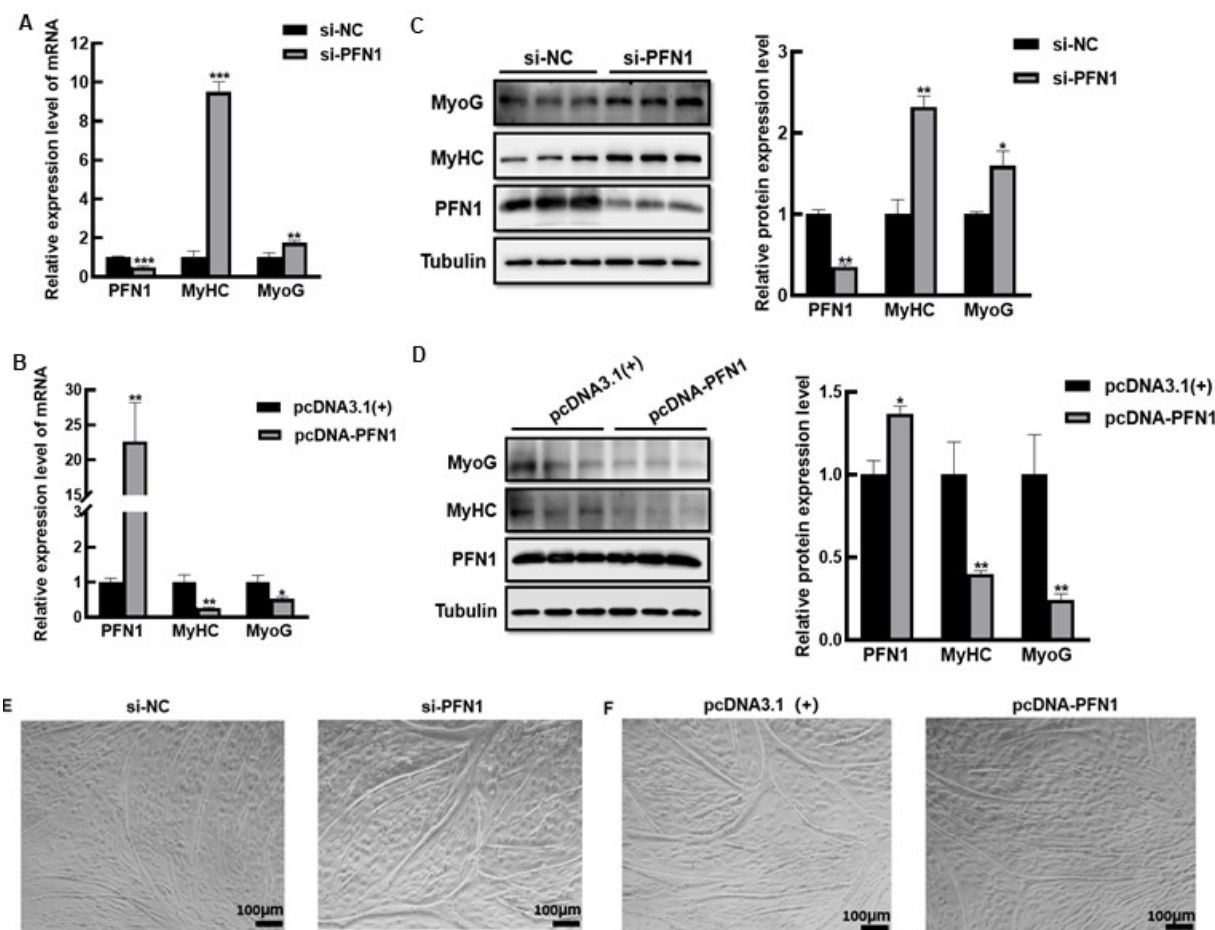
Figure 1. The effect of PFN1 on the differentiation of bovine skeletal muscle satellite cells: ( A ) qRT-PCR detection of mRNA expression level of differentiation marker genes in si-PFN1 or si-NC transfected DM2 myoblasts; ( B ) qRT-PCR detection of the mRNA expression level of differentiation marker genes in pcDNA-PFN1 or pcDNA3.1(+) transfected DM2 myoblasts; ( C ) Western blot and quantitative analysis of differentiation marker protein levels in si-PFN1 or si-NC transfected DM2 myoblasts; ( D ) Western blot and quantitative analysis of differentiation marker protein levels in pcDNA-PFN1 or pcDNA3.1(+) transfected DM2 myoblasts; ( E ) Myotube formation status in si-PFN1 or si-NC transfected DM2 myoblasts; ( F ) Myotube formation status during differentiation in pcDNA-PFN1 or pcDNA3.1(+) transfected DM2 myoblasts. si-NC stands for negative control, and pcDNA3.1(+) stands for empty vector control negative control. * p < 0.05, ** p < 0.01, and *** p < 0.001.